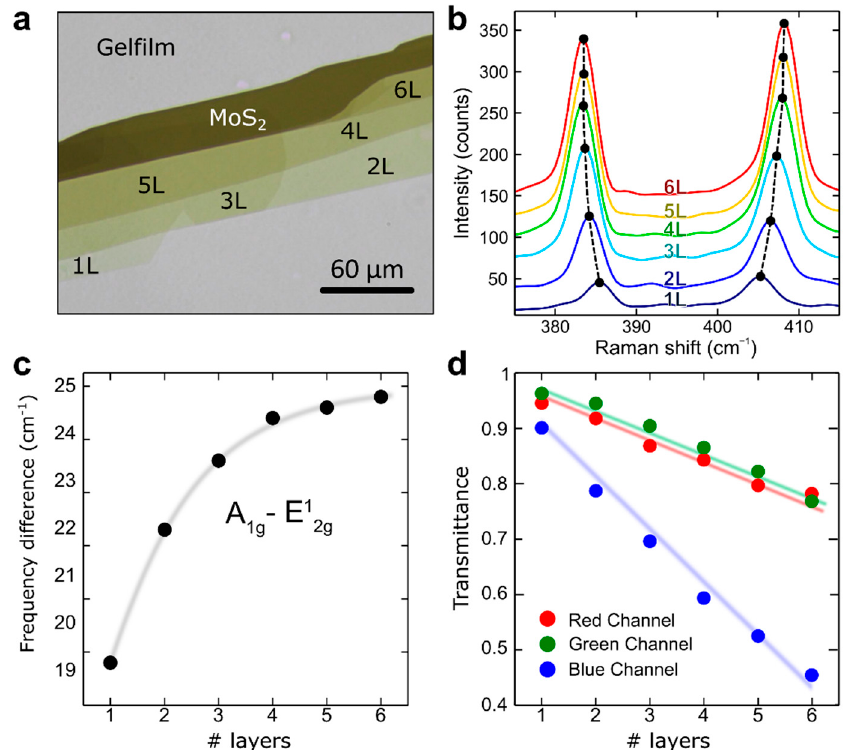
Figure 1. ( a ) Transmission mode optical image of a mechanically exfoliated MoS 2 flake on polydimethylsiloxane (PDMS) substrate; ( b ) Raman spectra measured on the different regions of the flakes; The thickness of the flake can be determined from the Raman shift difference between the A 1g and E 2g lines, shown in panel ( c ). Note that a flake-to-flake variation of up to ~0.5 cm − 1 can be found in the exfoliated flakes, and it would be the main cause of uncertainty in thickness determination through Raman spectroscopy; ( d ) Transmittance of the MoS 2 flake (extracted from the red, green, and blue channels of the transmission mode optical images), as a function of the number of layers.